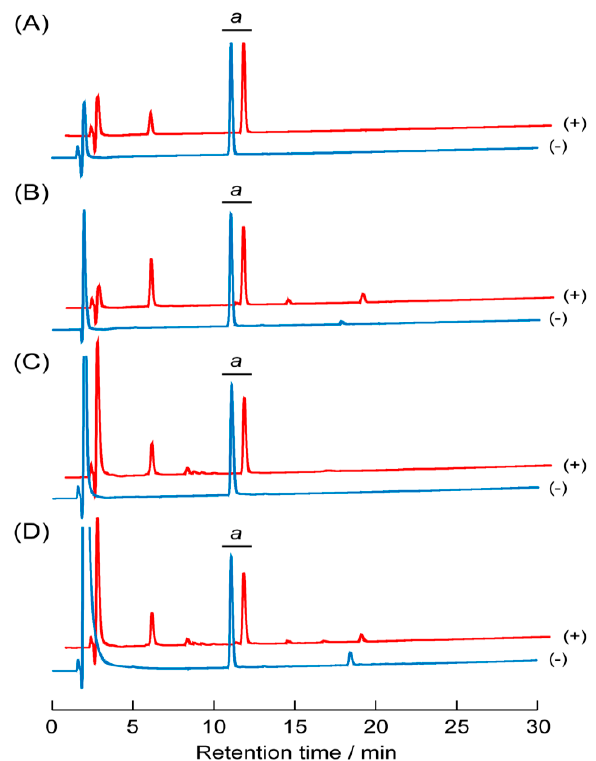
Figure 5. HPLC profiles of the reaction mixtures of ( A , C ) RU003 (100 µ M) and ( B , D ) RU003 (100 µ M) and Ape5-TD (10 µ M), matured for 5 days, followed by proteolytic degradation with ( A , B ) trypsin from bovine pancreas (RU003 / trypsin = 490 / 1, w / w ) and ( C , D ) chymotrypsin from bovine pancreas (RU003 / chymotrypsin = 1 / 1, w / w ). Samples were incubated at 40 ◦ C for 1 h and analyzed by reversed-phase HPLC. The symbols “ + ” and “-“ in parentheses indicate HPLC profiles “with” and “without” proteases, respectively. “ a ” denotes the peaks for RU003.